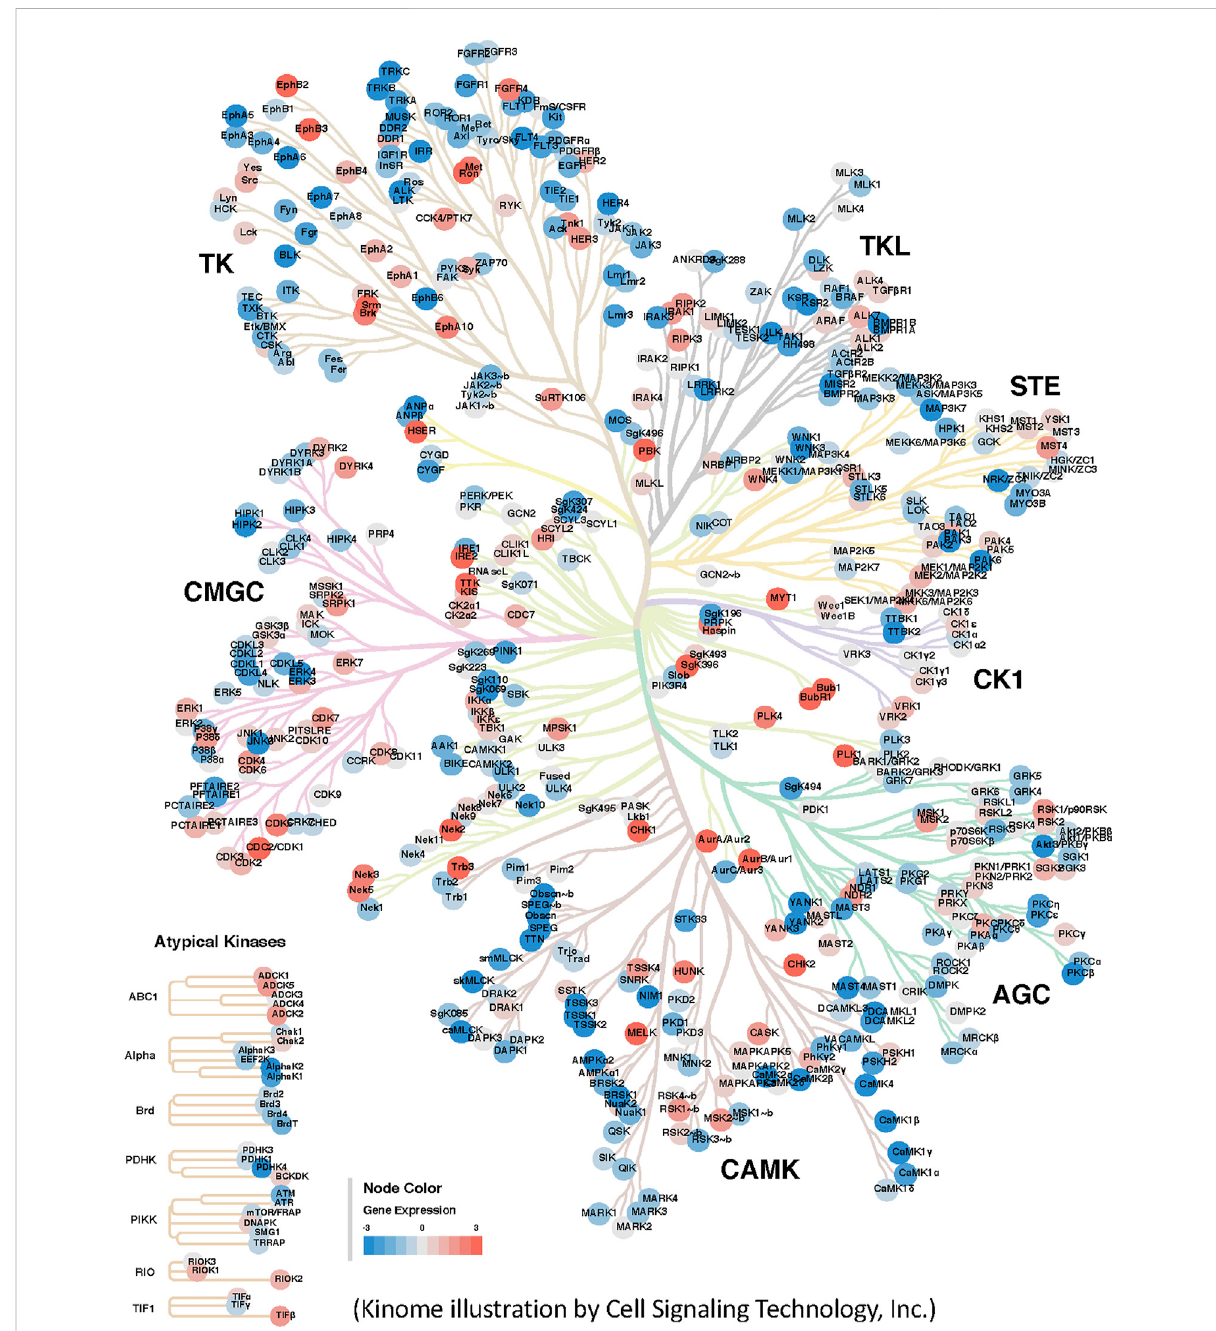
FIGURE 1 Visualization of differentially expressed kinases in cancer. Differential expression of kinases in Colon Adenocarcinoma was estimated using 100 TCGA-COAD RNA-Seq tumor samples (cases) and 165 normal samples (controls) derived from various human tissues by (Suntsova et al., 2019). Raw gene counts of both samples were downloaded from the Genomic Data Commons and Sequence Read Archive (SRA ID: SRP163252) respectively. DEseq2Rpackagewas usedto normalizethedata and estimate thedifferentialexpressionofgenes. The log2 ratio ofdifferentially expressed kinases were then extracted and used as quantitative input data within the CORAL web application (Metz et al., 2018). A few prominent differentially expressed kinases such as MET and RON as one of the highly expressed kinases in the